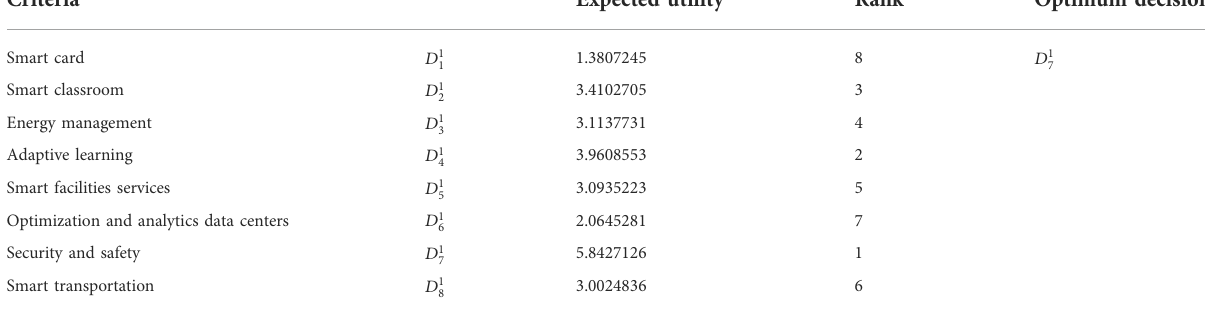
TABLE 9 Optimum